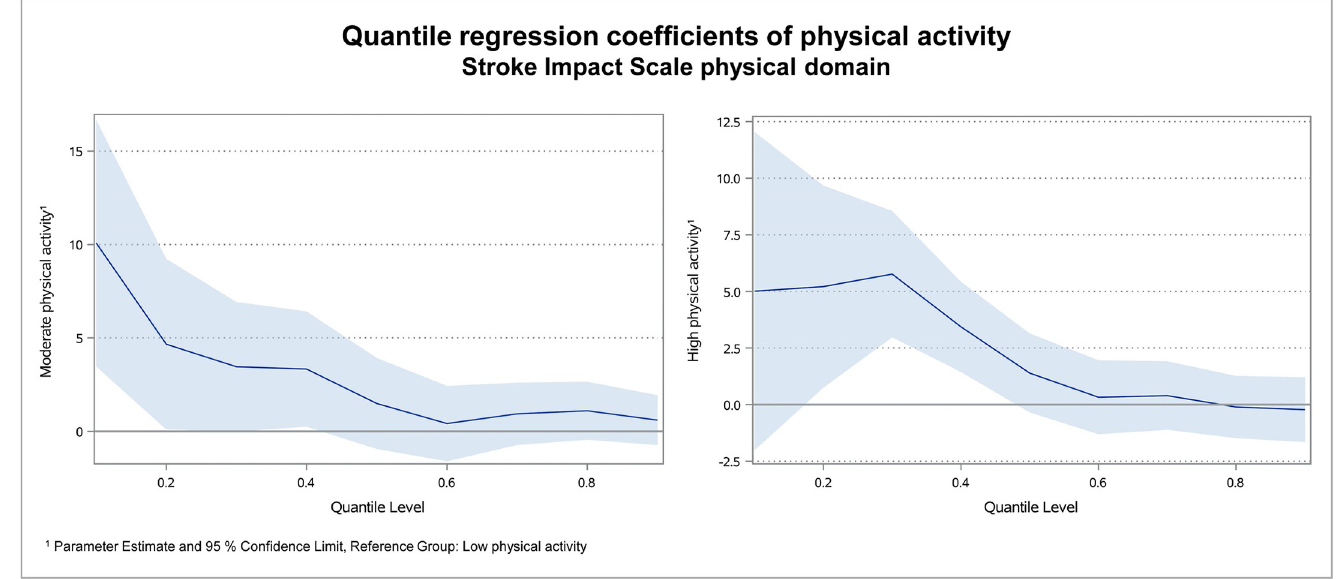
Fig 1. Quantile regression coefficients of physical activity for the SIS physical domain.